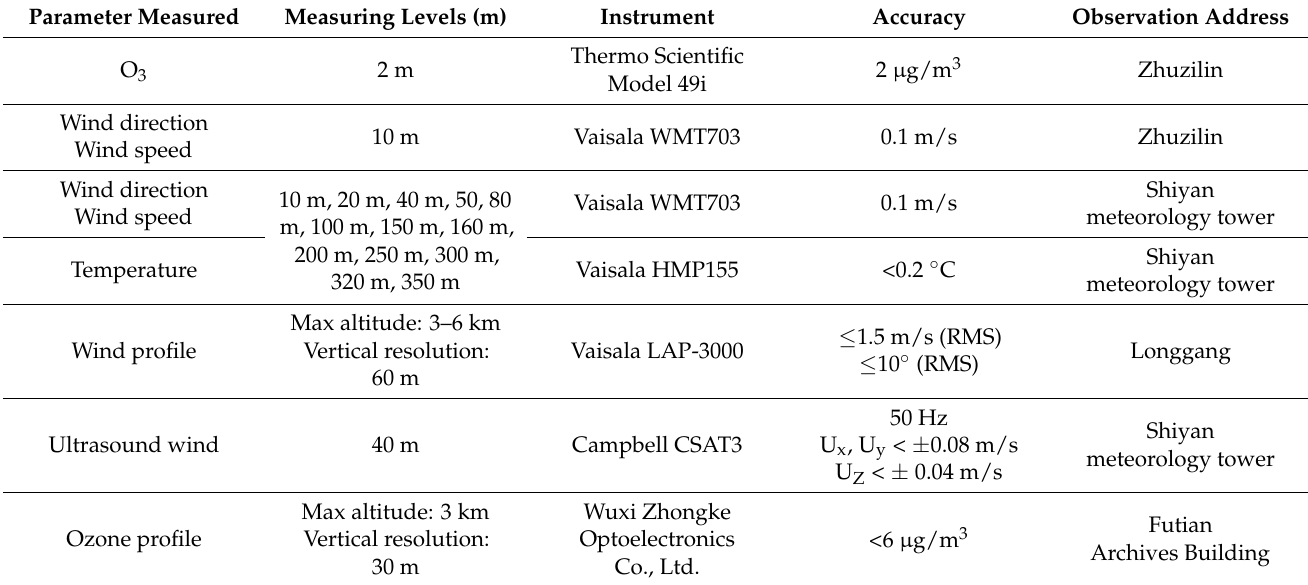
Table 1. Description of the